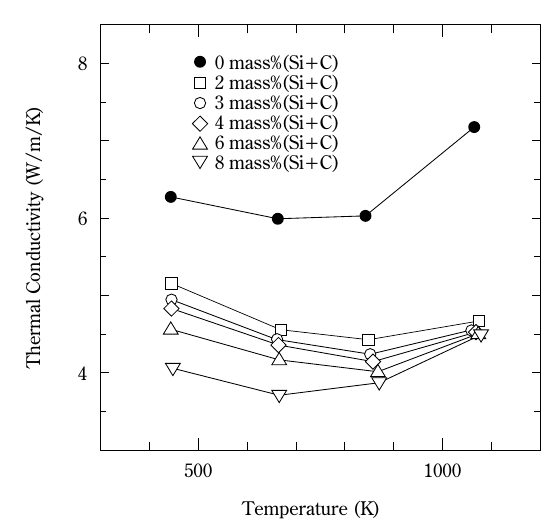
Fig. 6 Temperature dependence of the thermal conductivity for the sintered p-type Fe 0.92 Mn 0.08 Si 2 with addition of x mass% (Si (cid:4)